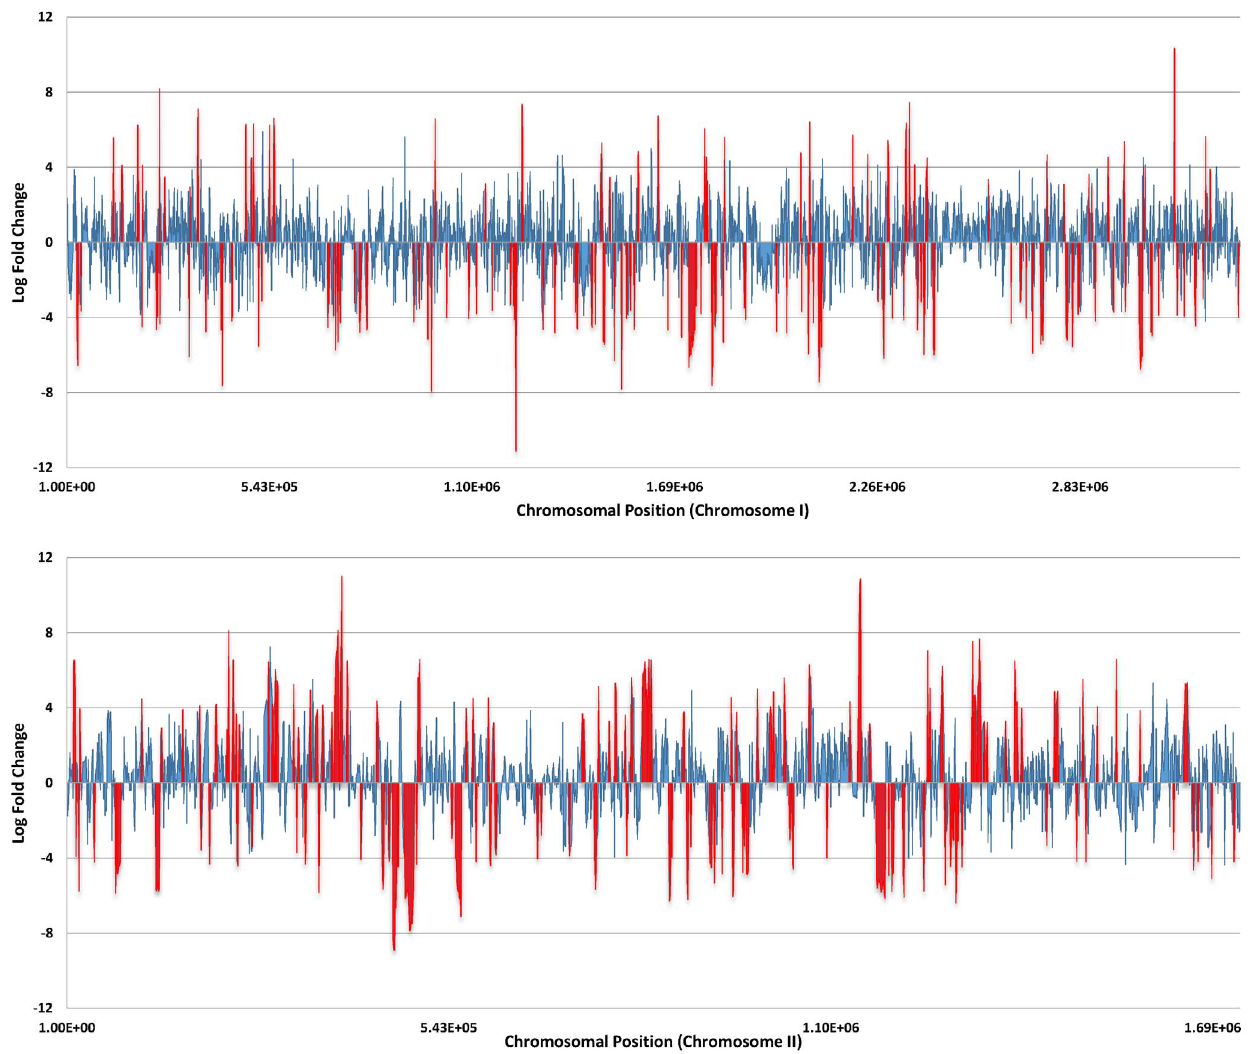
Fig. 2. Linear compressed view of differentially expressed genes in V. vulnificus exposed to human serum (relative to artificial seawater). These charts show a compressed view of the differentially expressed genes in V. vulnificus CMCP6 by chromosome (top; chromosome I, bottom; chromosome II) and allows quick identification of clusters of differentially expressed genes, both positive and negative. The y-axis shows the log fold change and the x-axis is the nucleotide position of the chromosome. Blue bars represent non-significant DE genes whereas red bars show genes that are significantly differentially expressed (p , 0.0001) in relation to artificial